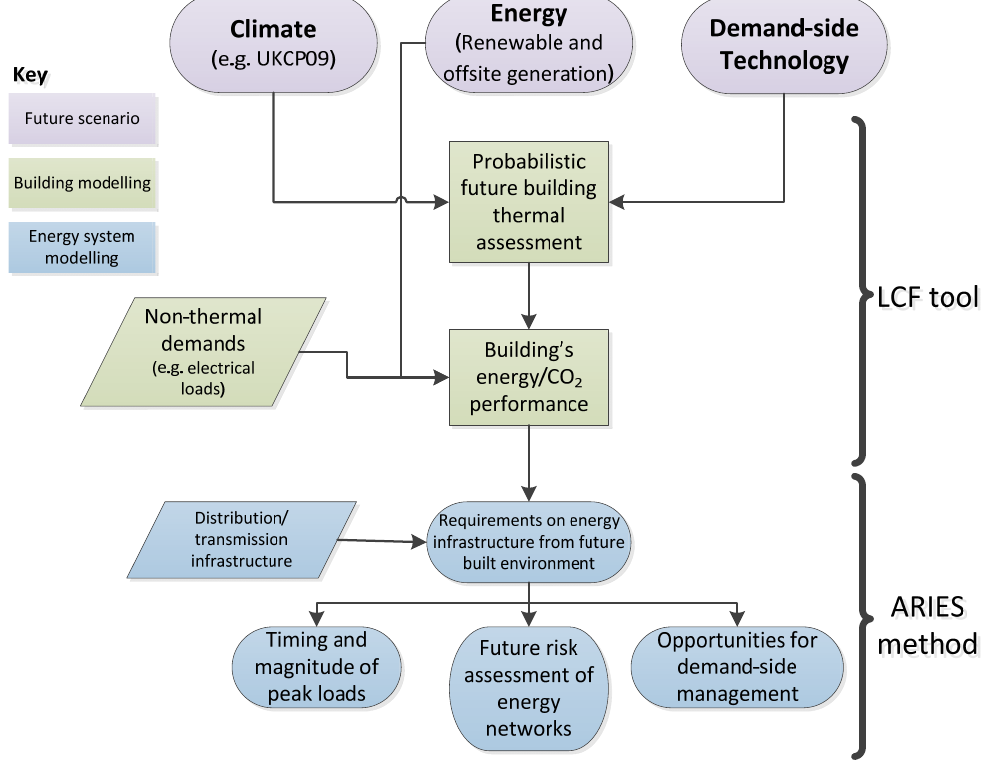
Figure 8. Use of LCF and Adaptation and Resilience In Energy Systems (ARIES) methodologies for identifying future forms of energy provision for the built